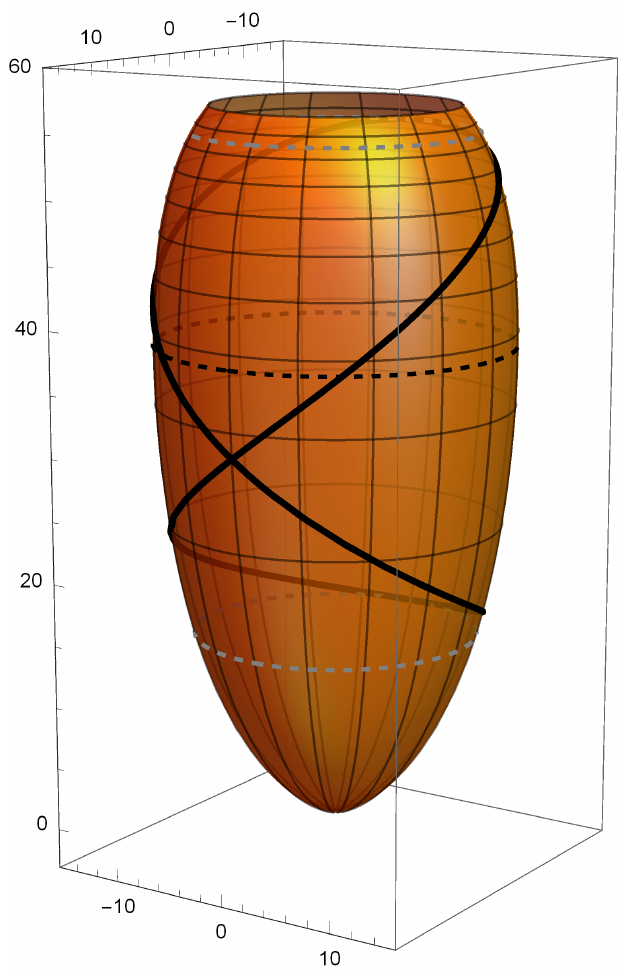
Figure 10. Critical closed geodesic orbit with two turning points at r tc = 11.194 ‘vertex latitudes’. A = 525.6 and B =